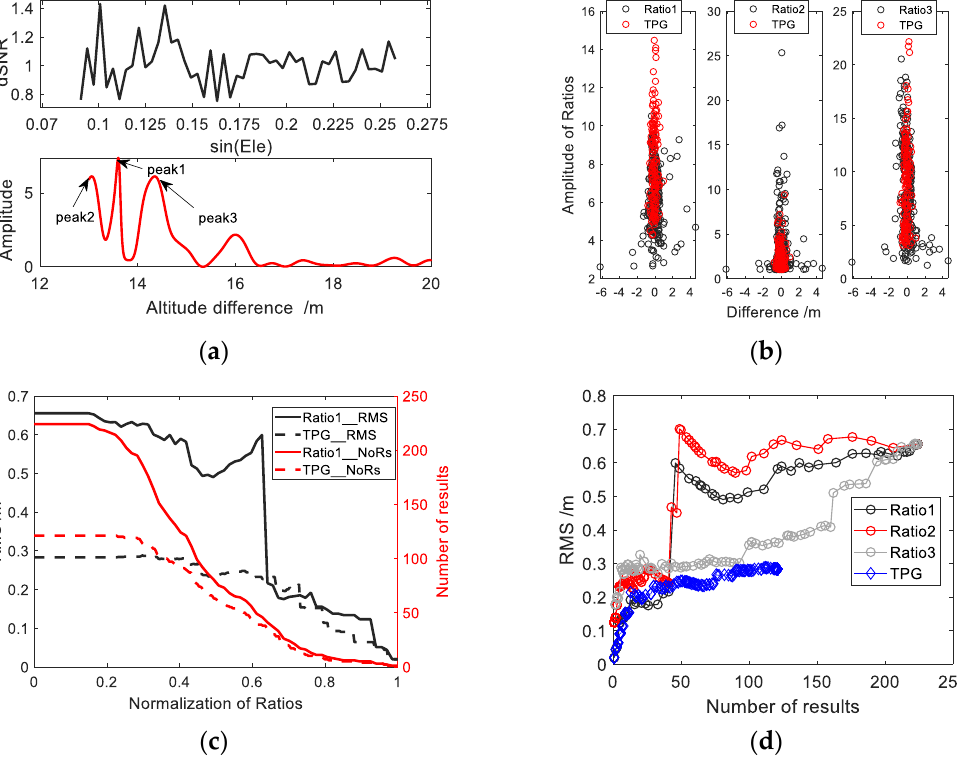
Figure 9. ( a ) In the case of multiple peaks, the frequency corresponding to the maximum amplitude is not the correct value; ( b ) Results after adding TPG quality control method at BRST station. The X axis represents the difference between the measurements of the tidal station and the water level results obtained by GNSS-IR technique; ( c ) Comparison of TPG and Ratio1 threshold settings for two quality control methods; ( d ) Comparison of TPG and three threshold setting quality control methods with respect to accuracy and number of results.